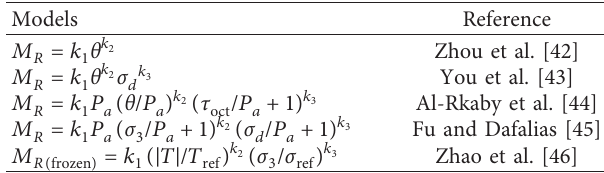
Table 3: Common resilient modulus models.